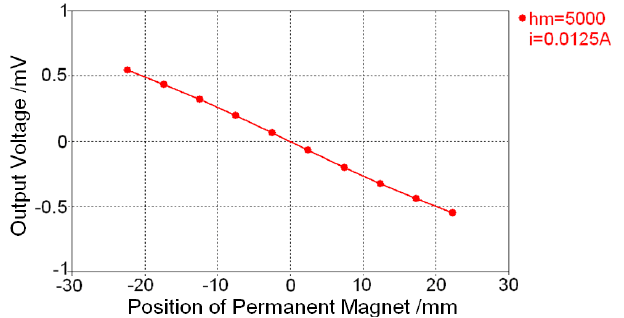
Figure 13. Low frequency calculation